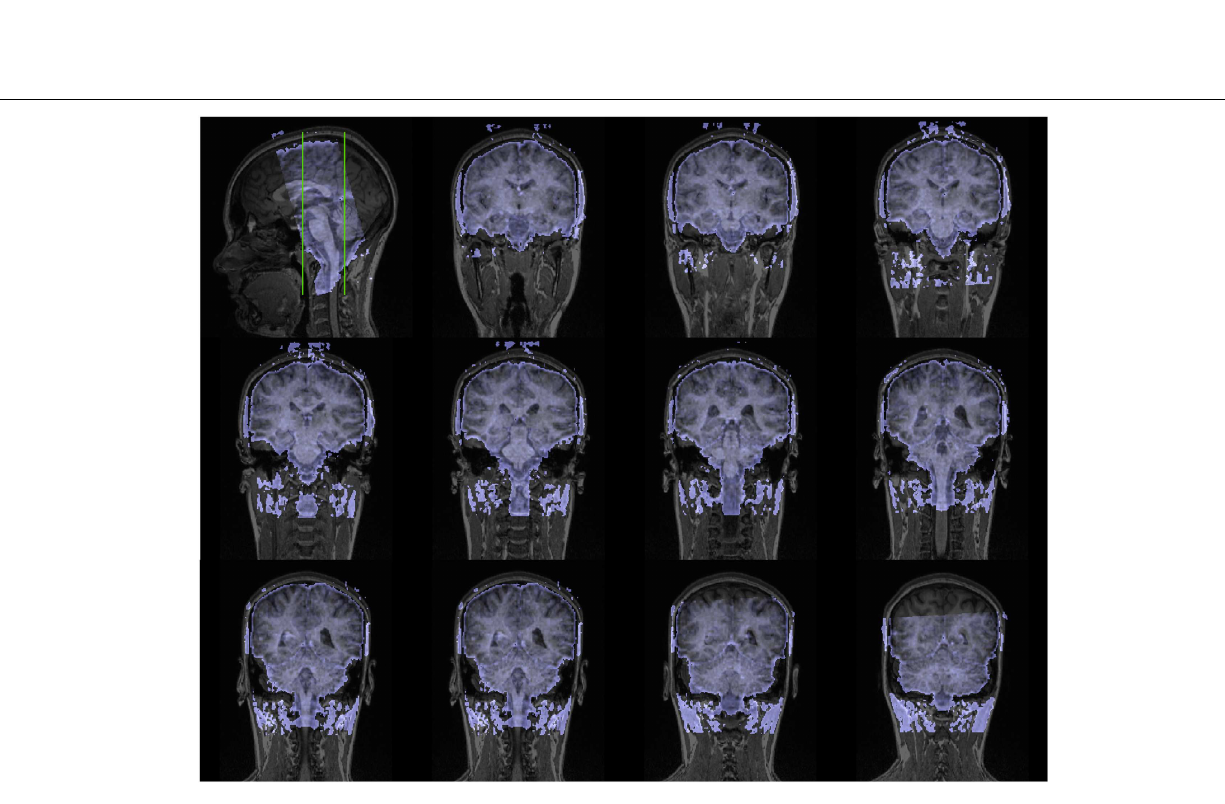
FIGUREA2 | Section (between green lines in mid – saggital view) of the functional mean BOLD – data coregistered to the anatomical scan (neurological convention left =